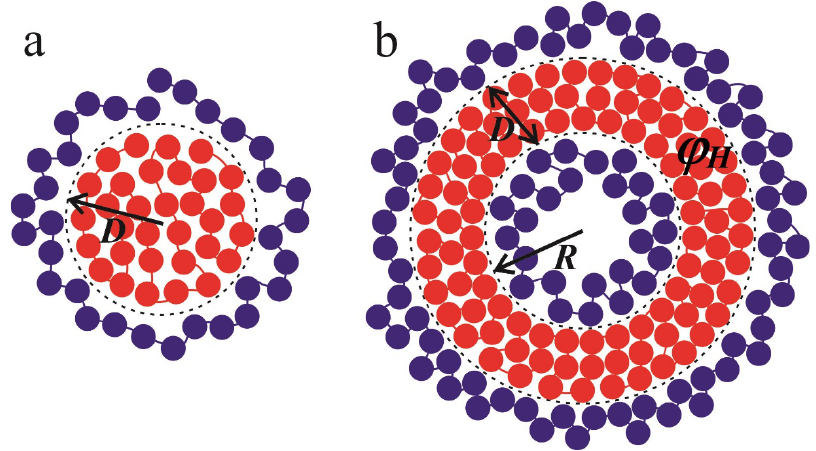
Figure 9. The schematic representation of spherical core – shell ( a ) and vesicular structures ( b ) considered in the framework of the analytical theory. The red circles depict monomer units of the polycations; the polyanions are shown by blue circles. The dashed lines represent the boundaries of the hydrophobic region. The radius of the spherical hydrophobic core is denoted by D , whereas the radius of the cavity equals R and the thickness of the spherical layer is D .